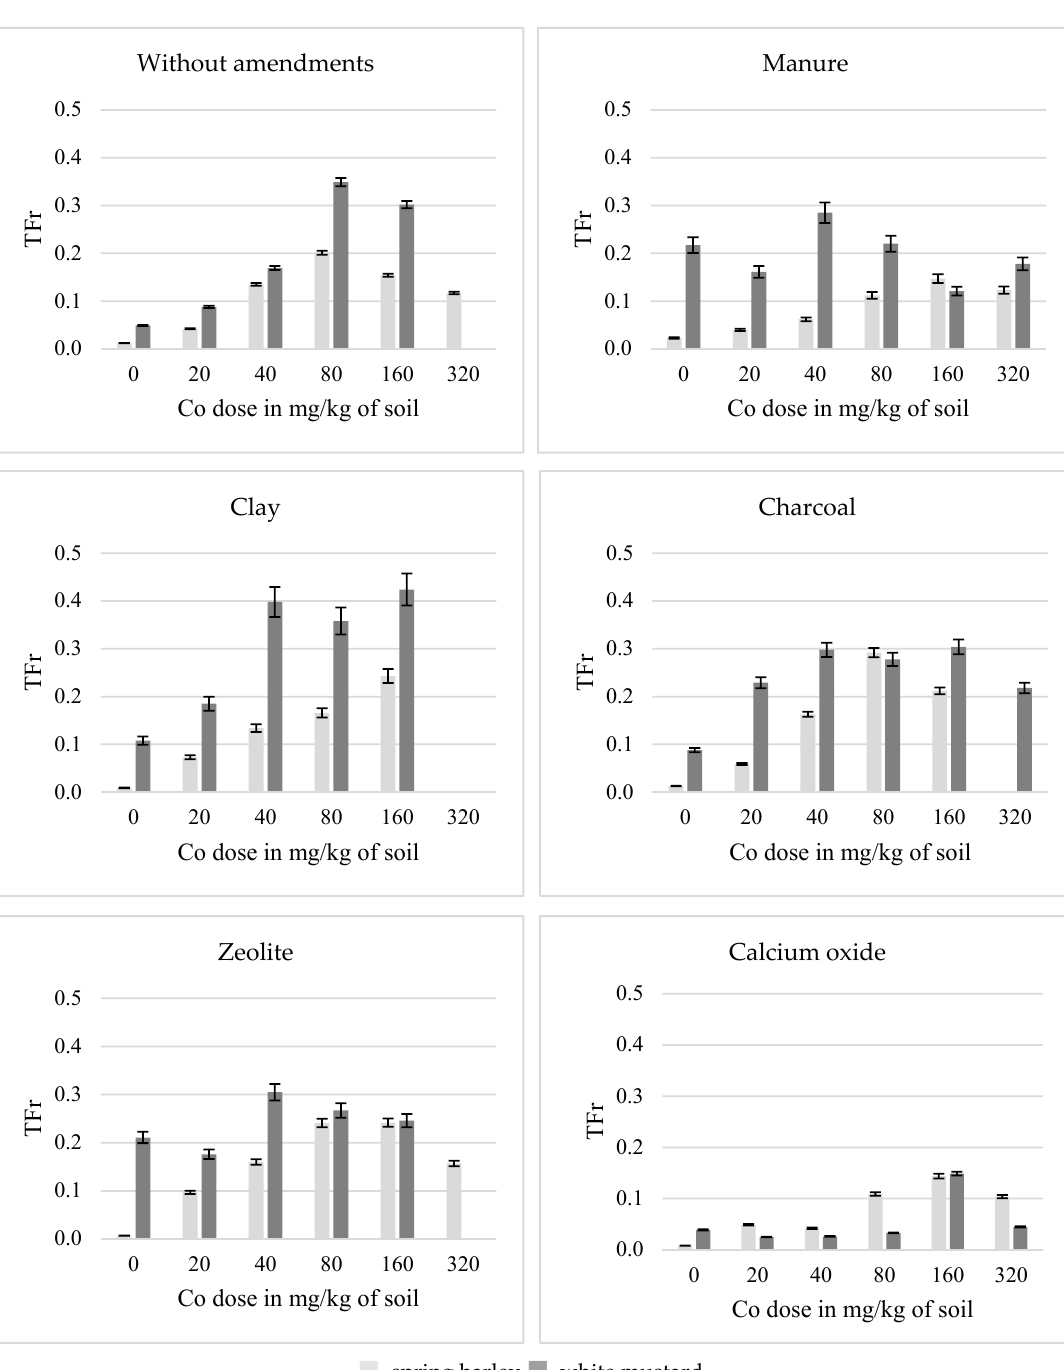
Figure 5. Transfer factor (TFr) of cobalt in spring barley and white mustard.